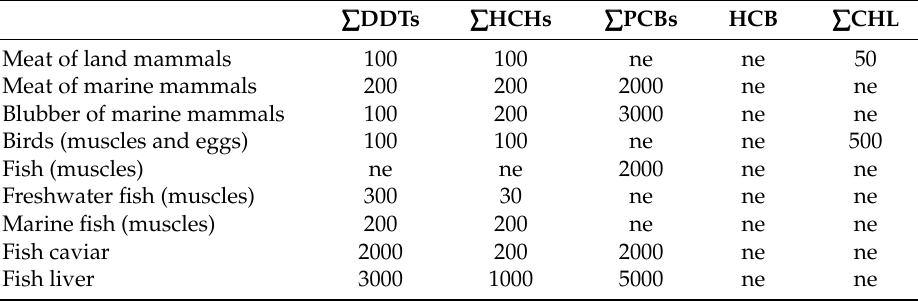
Table 4. Russian Allowable Levels of POPs in raw foods, µ g/kg ww [17]. ∑∑∑ DDTs ∑∑∑ HCHs ∑∑∑ PCBs HCB ∑∑∑ CHL Meat of land mammals 100